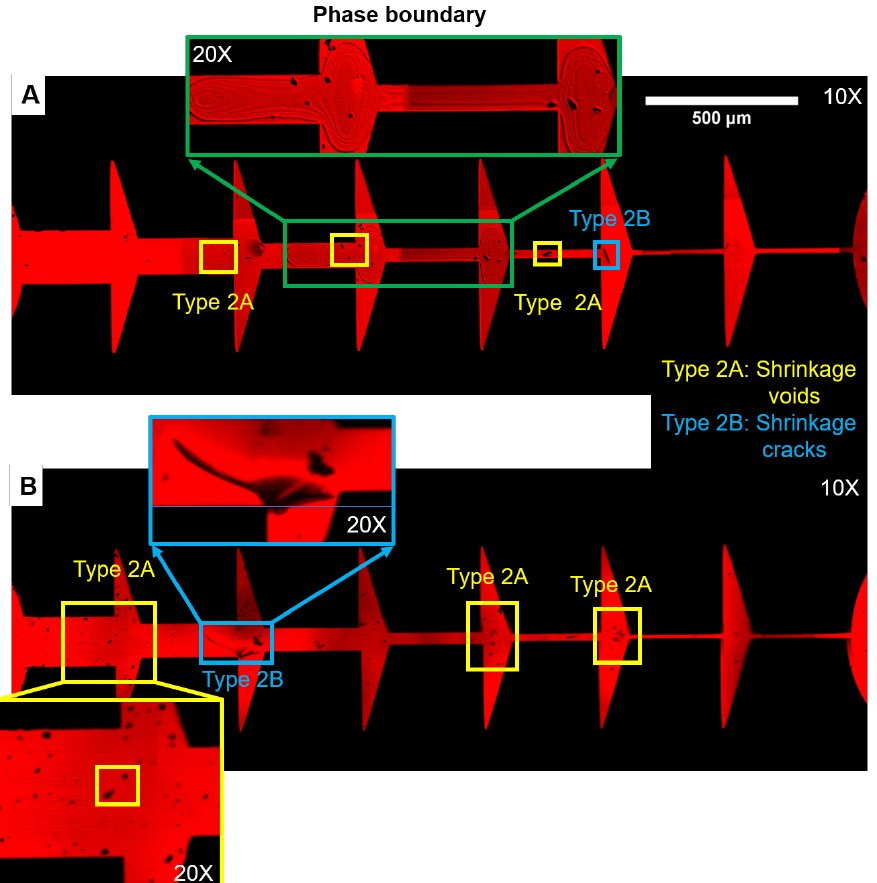
Figure 12. Confocal images of two micromodels impregnated under a vacuum. Two compositions of resin and toluene were used: ( A ) epoxy mixed with 5% toluene and ( B ) epoxy mixed with 30% toluene. In model A, a phase boundary between toluene and epoxy was detected. Shrinkage defects, especially type 2A, were visibly more abundant in model B where the toluene fraction was